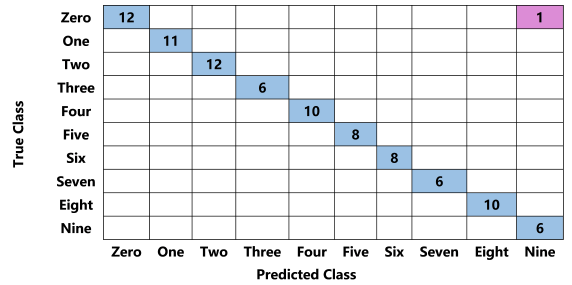
Figure 6. The confusion matrix of the test set. The color blue indicates the inference is correct while the pink indicates the inference is